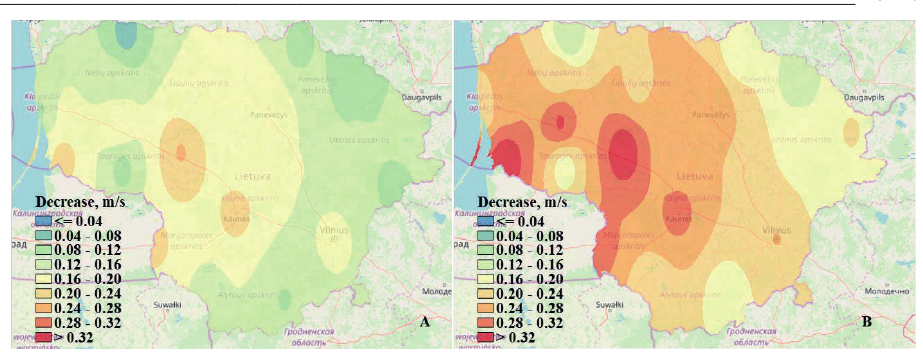
Fig. 4. Wind speed change in the future, comparing to CN: (A) 2040–2050; ( B) 2090 –2100.